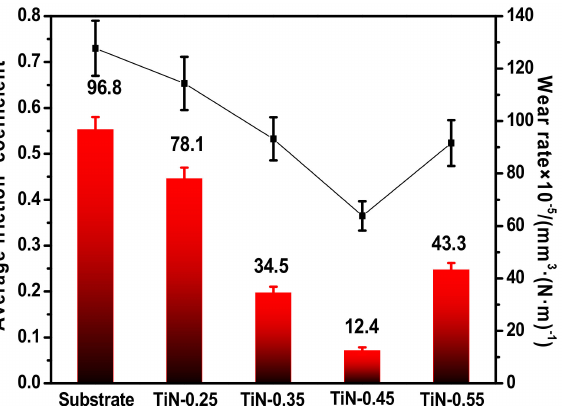
Figure 7. Wear rates and friction coefficient for the steel substrate and the TiN coating sliding against GCr15 steel ball under unlubricated conditions. (Line graph is friction coefficient, and bar graph is wear